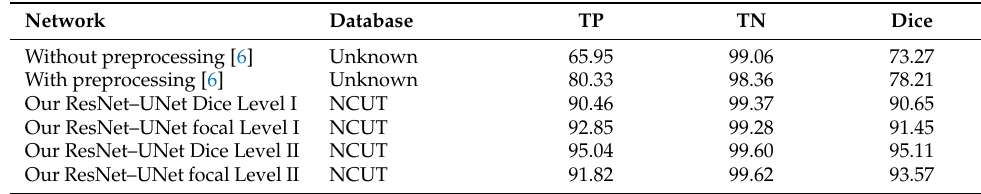
Table 7. Comparison of the